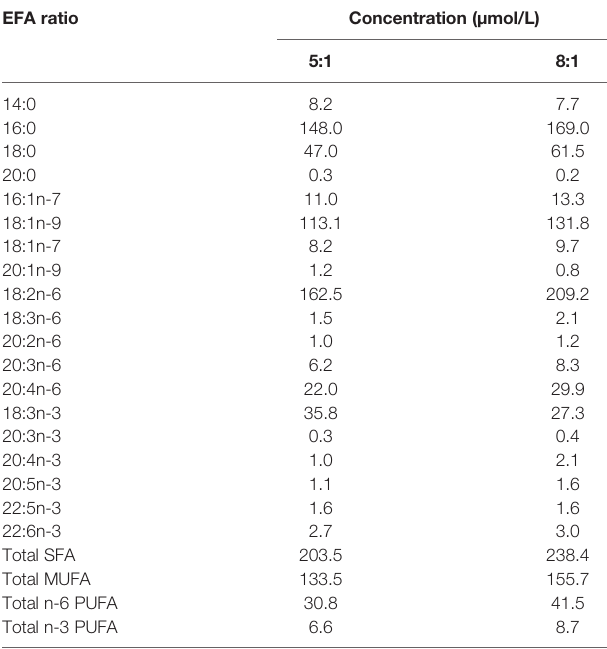
TABLE 1 | Cell culture medium fatty acid